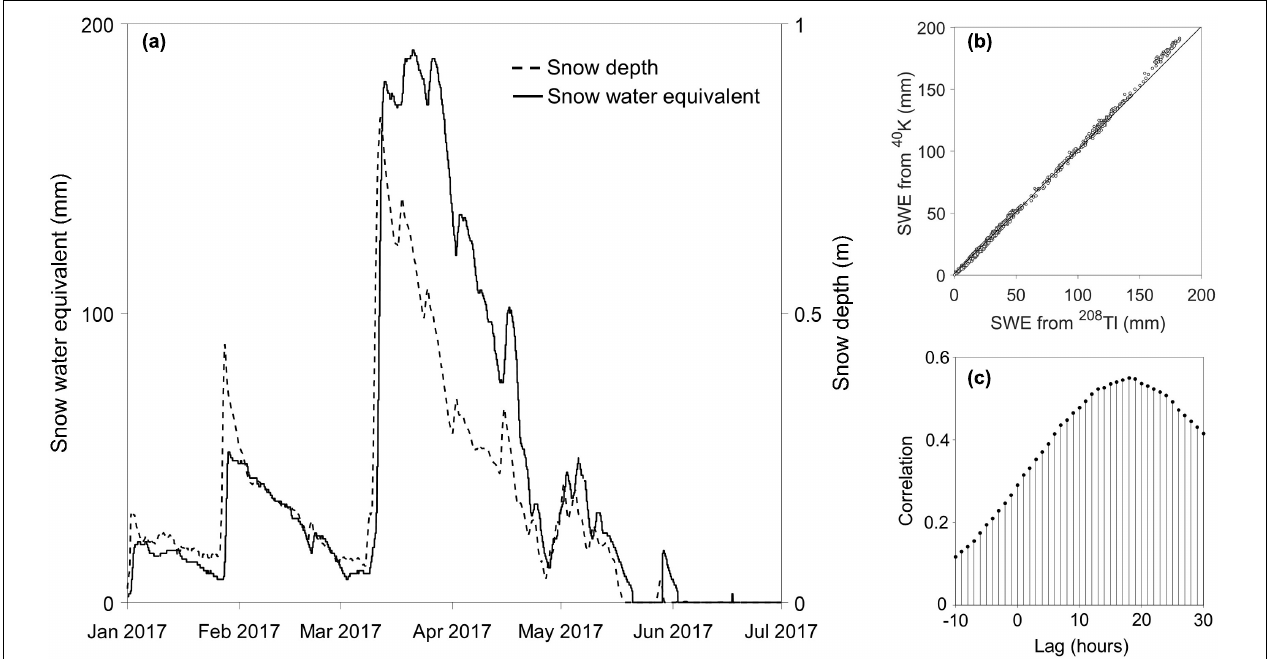
FIGURE 2 | Time delay and isotope comparison for the CS725. (a) Example of the time delay between SWE measurements and snow depth measurements between January 2017 and July 2017. (b) SWE measurements derived from Potassium ( 40 K) versus Thallium ( 208 Tl) isotopes measured by the CS725. (c) Cross correlation plot between snow depth and SWE demonstrating that SWE most frequently lags behind snow depth by 18 h.